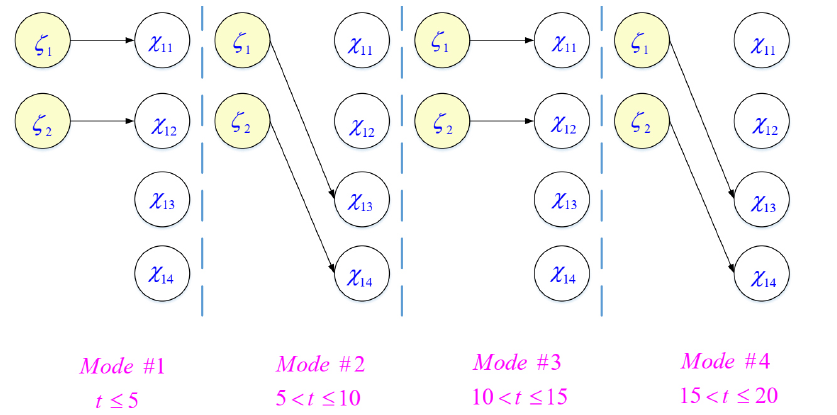
Figure 5. The multi-switching modes.